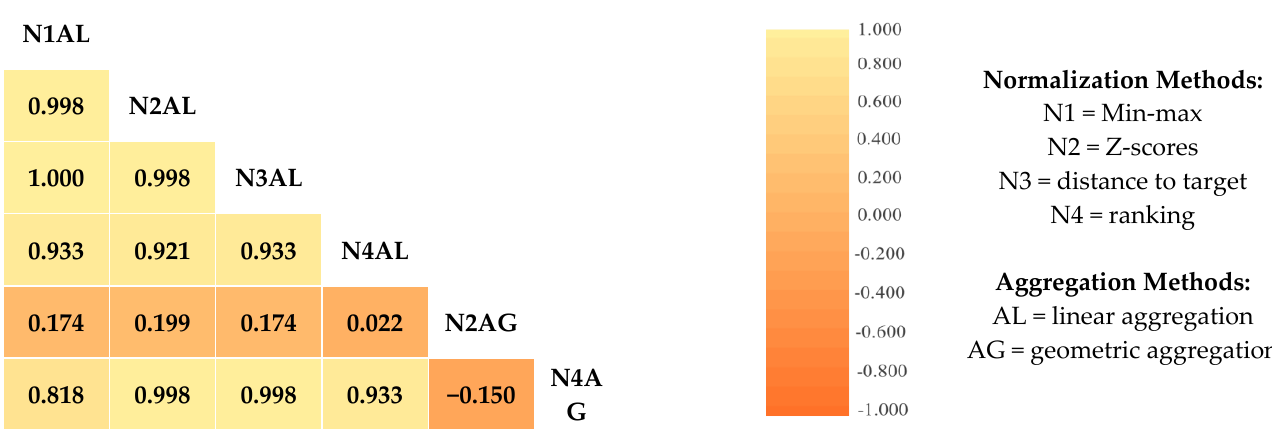
Figure 3. Correlation between the flood vulnerability indexes based on the different normalization and aggregation methods. Numbers represent Spearman correlation coefficients; colors represent the strength of the correlation.